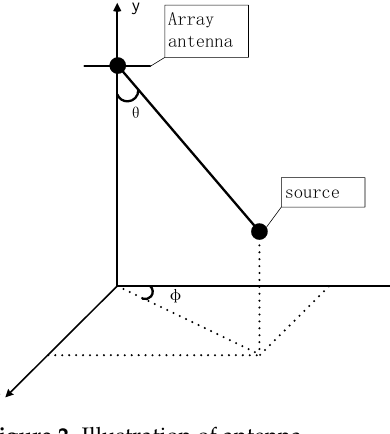
Figure 2. Illustration of antenna.